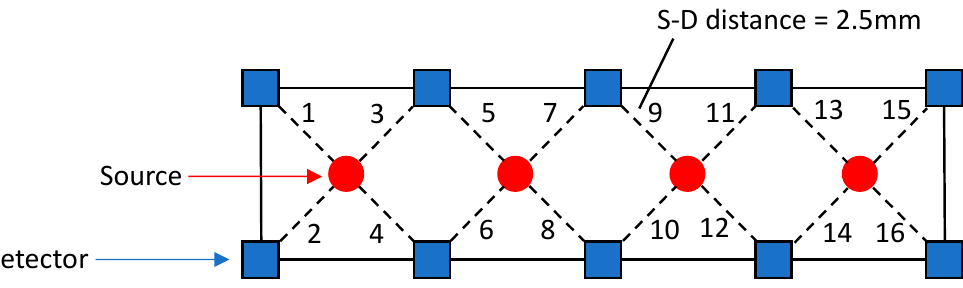
Figure 2. Probe diagram on the prefrontal cortex. Red circles are sources, and blue squares are detectors. All source-detector distances are 2.5 cm.